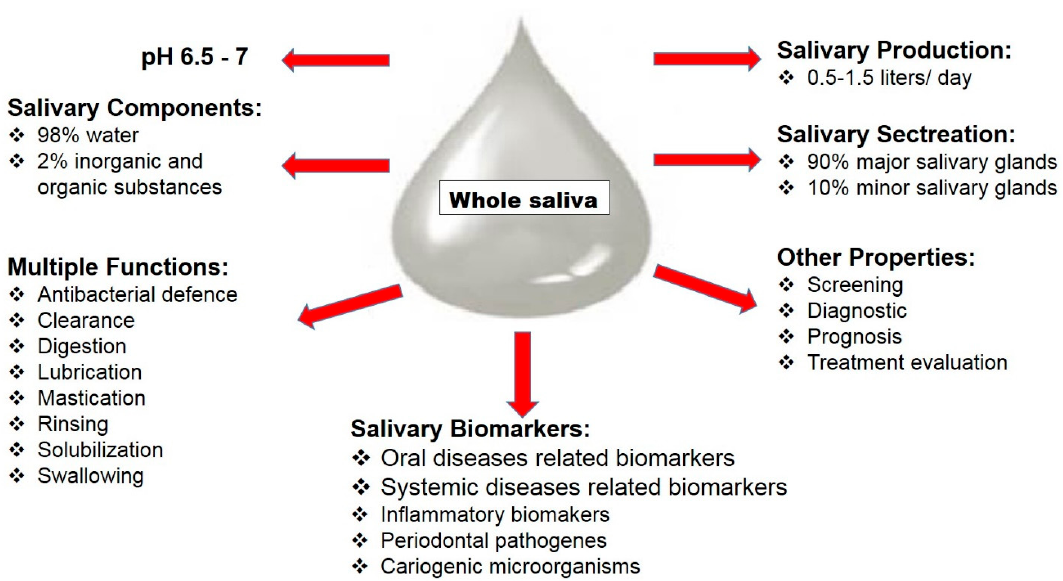
Figure 1. Components, properties and secretion of human whole saliva.